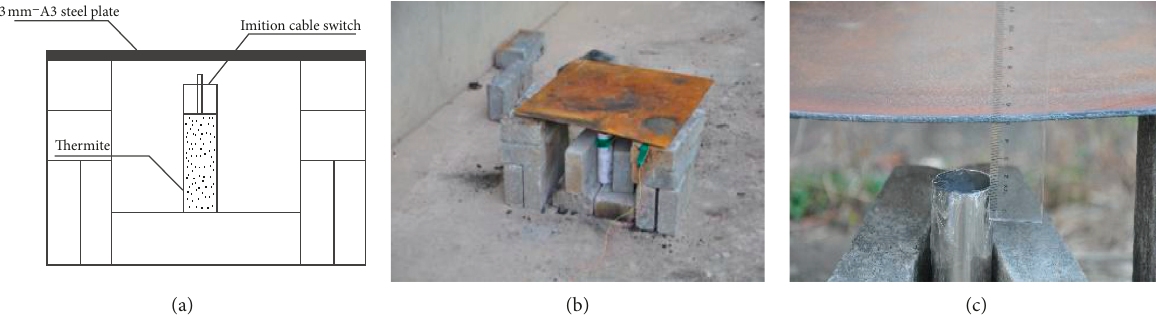
Figure 1: Schematic demonstration (a) and actual photographs (b, c) of steel plates ablated by thermite. (a) Sketch map. (b) Physical map 1. (c) Physical map 2.